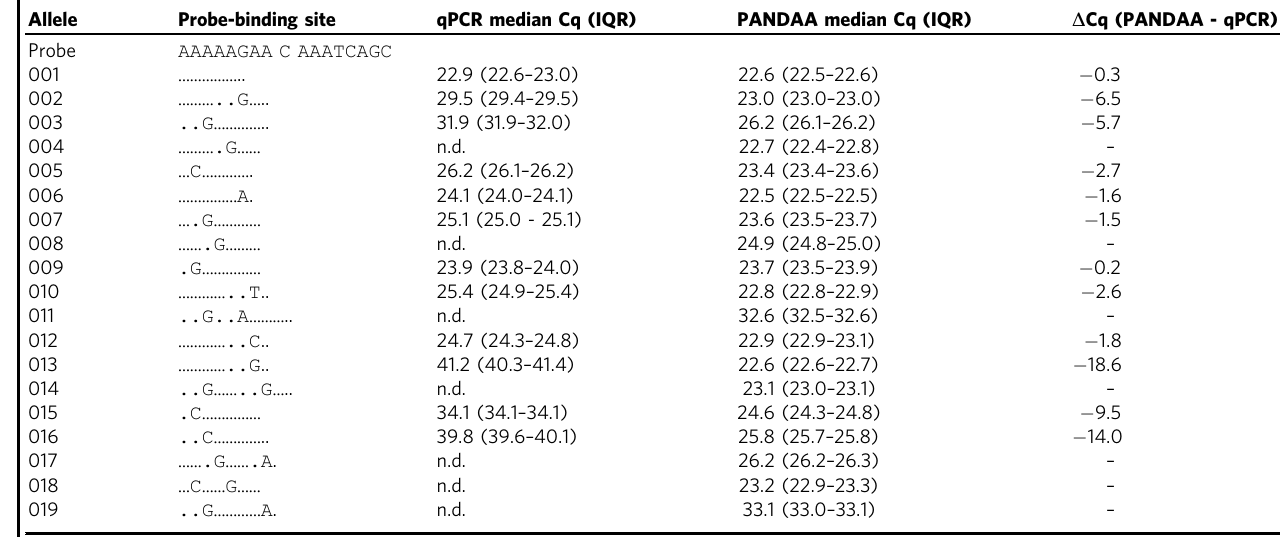
Table 2 PANDAA improves sensitivity to detect single nucleotide changes in HIV-1 compared to conventional qPCR. Allele Probe-binding site